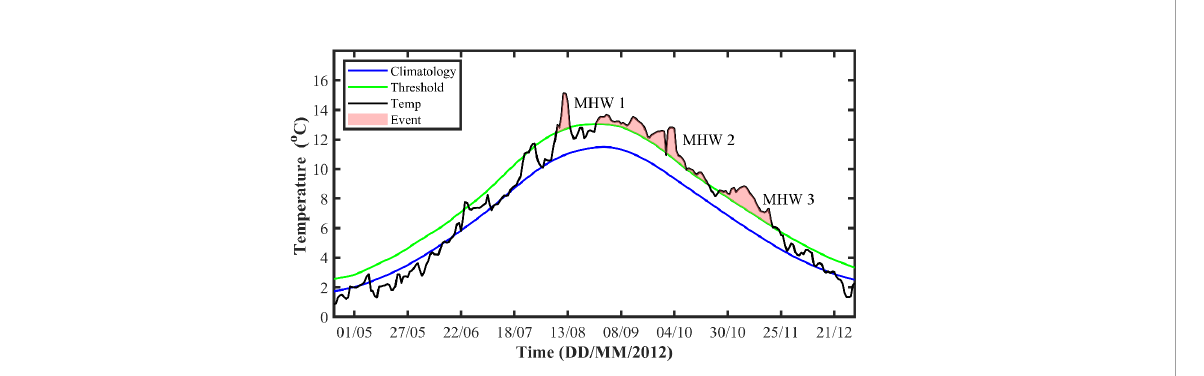
FIGURE 1 Identi fi cation of marine heatwaves at an arbitrary point (159.125°E, 49.125°N) in the WNPCC area between August 1 and December 21, 2012. The blue, green, and black curves represent the average climate temperature (1982 ~ 2014), the 90th percentile threshold value, and the point ’ s daily sea surface temperature curves, respectively. The reddish shading indicates three marine heatwave